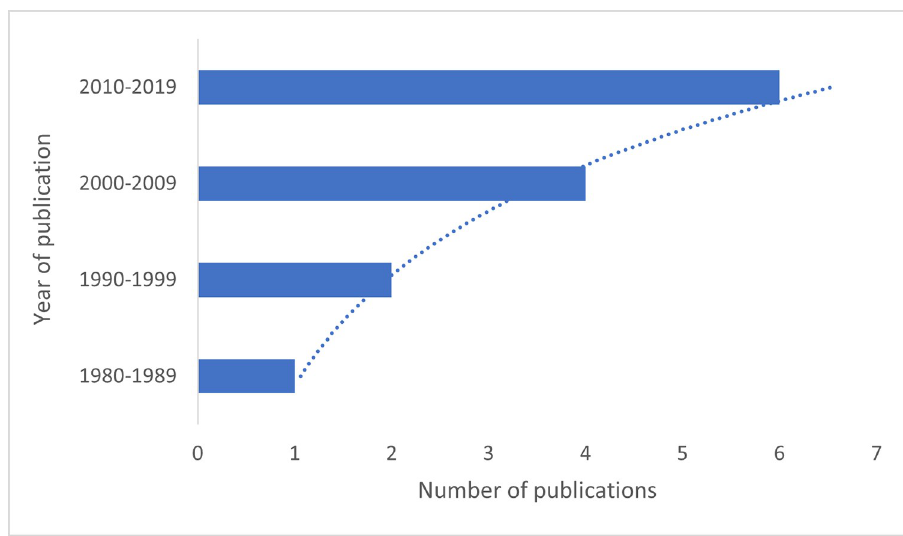
Fig 2. Diagram showing studies based on year of